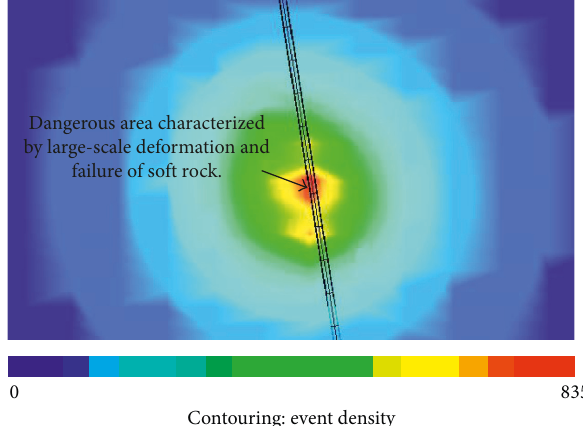
Figure 8: Microseismic event density nephogram at the time of soft rock